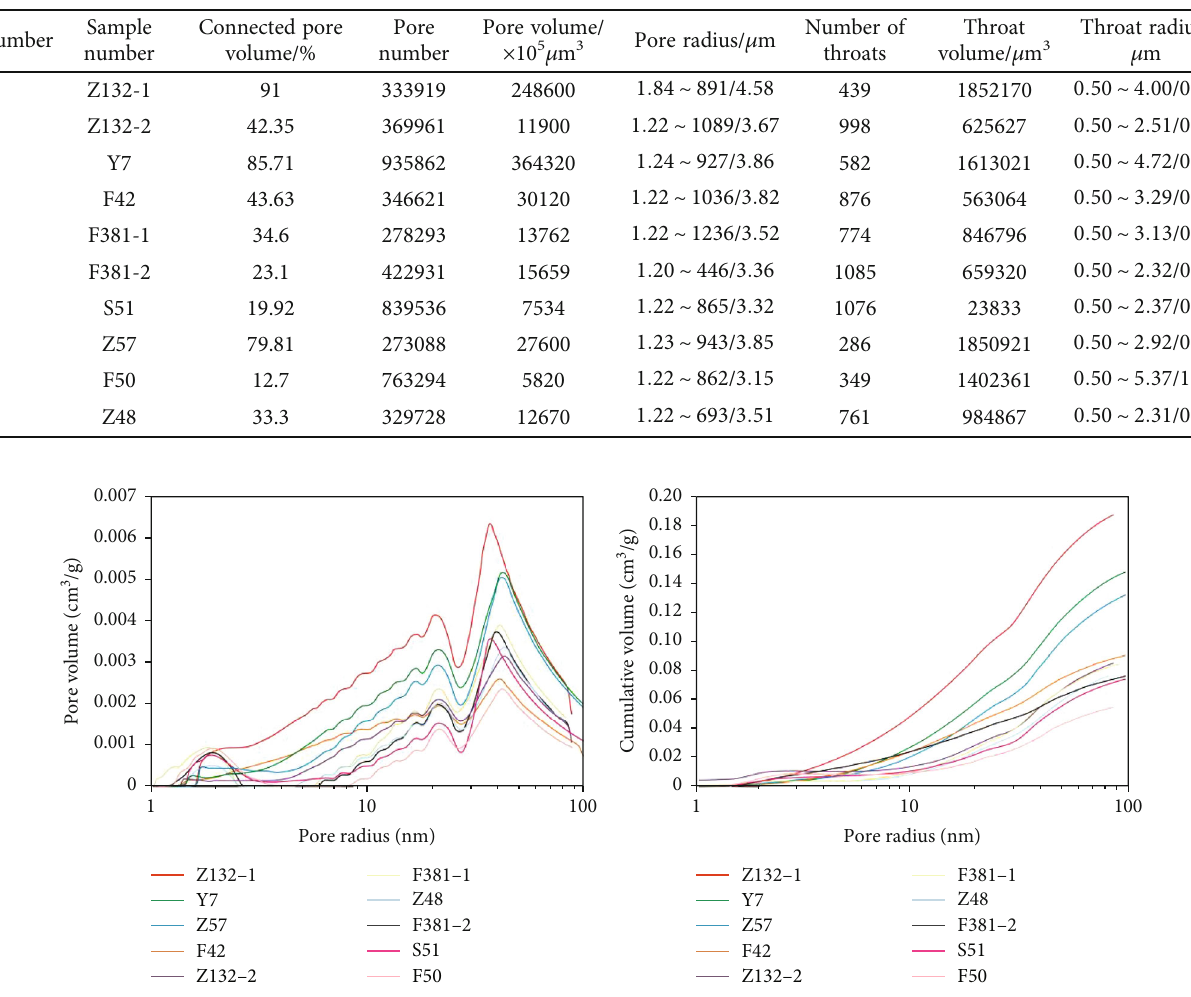
Table 3: Micro-CT results of tight sandstone in the 4 th of Quantou Formation.